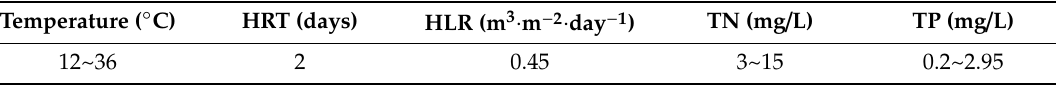
Table 2. Operating conditions for new aquatic constructed